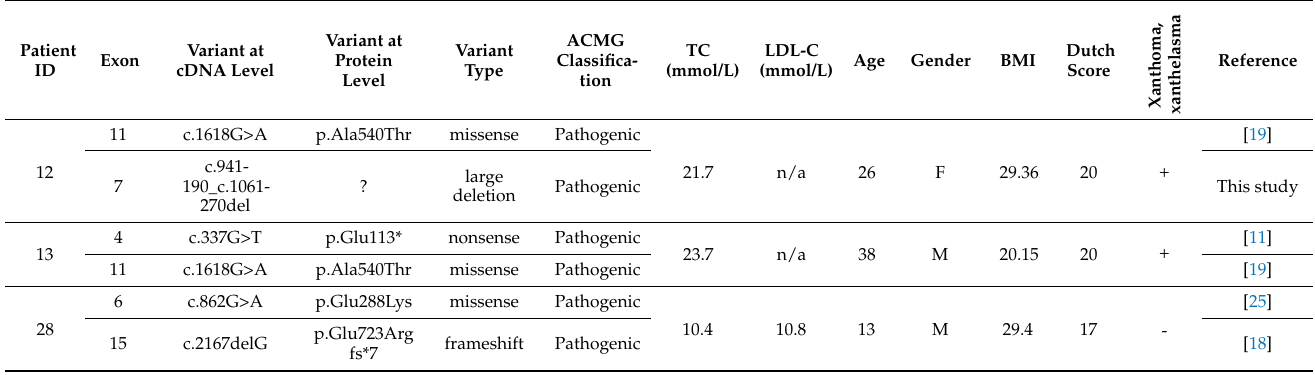
Table 3. Clinical and phenotypic data on Hungarian patients with LDLR variants and detailed summary of LDLR variants—patients with compound heterozygous LDLR variants.